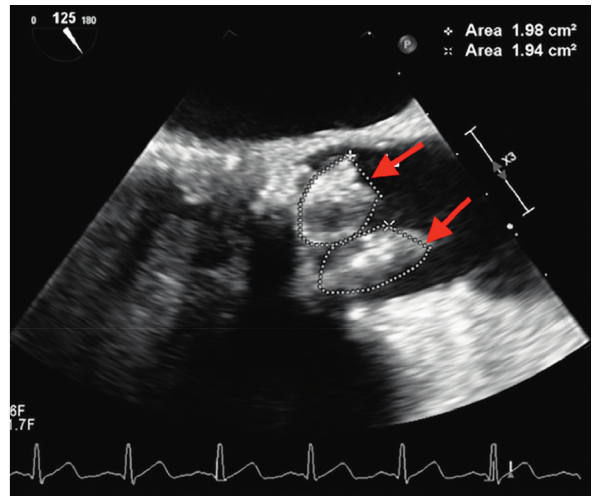
Figure 2: Transesophageal echocardiography showing two masses of approximately two cm 2 each of mobile vegetations on the bio- prosthetic aortic